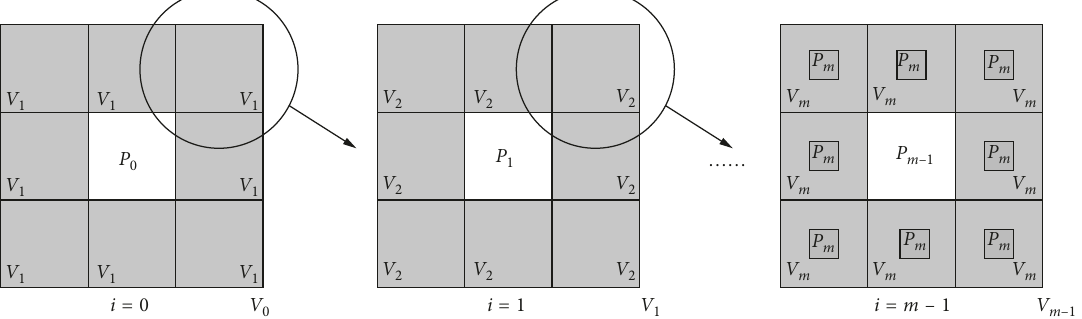
Figure 2: Schematic diagram of fractal porous medium (Sierpinski